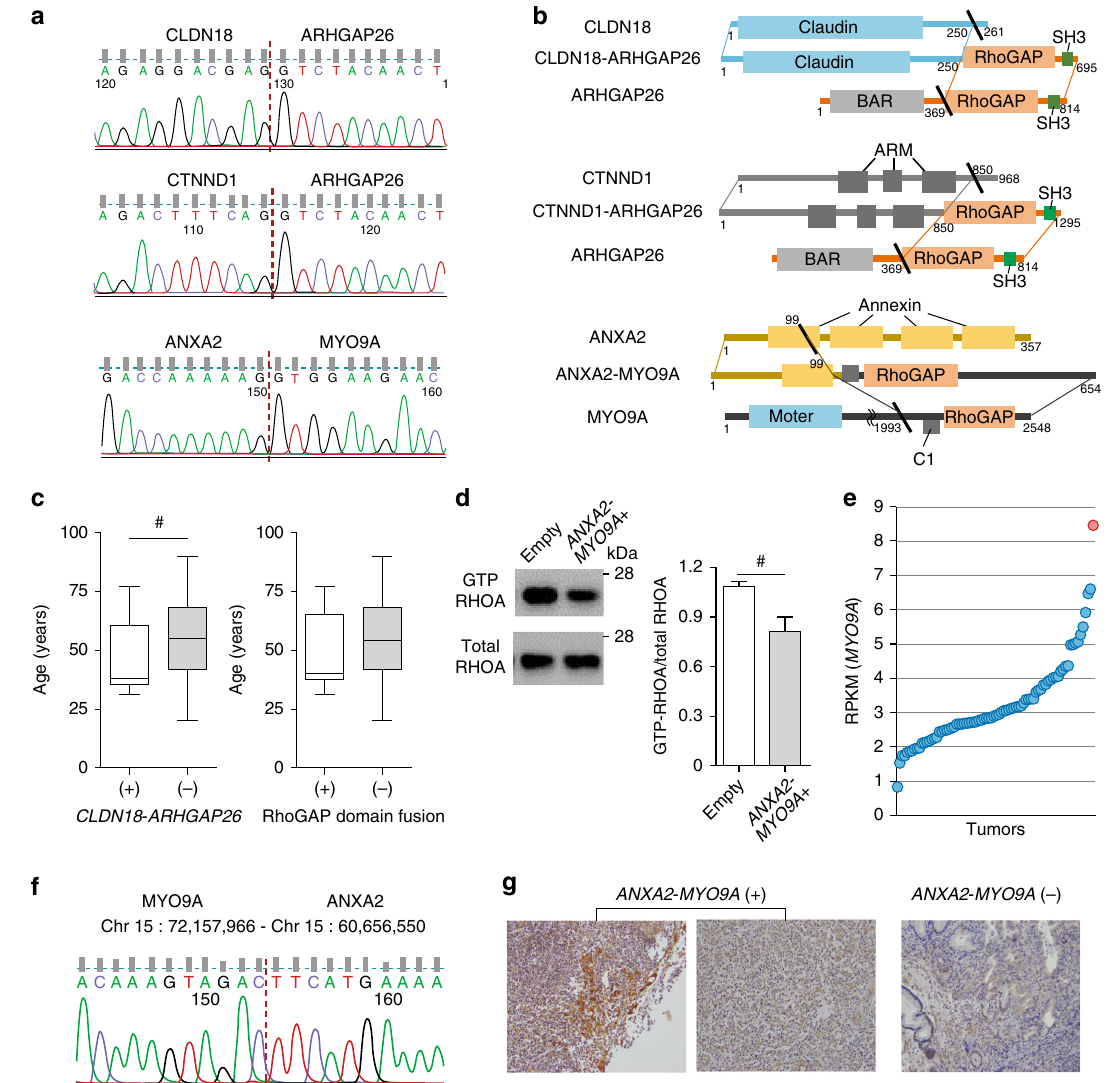
Fig. 2 Schematic representation of three recurrent RhoGAP domain-containing fusions ( a ) Chromatogram for the RT-PCR sequencing data. Dotted red lines, mRNA breakpoints. ( b ) Top panel, the CLDN18-ARHGAP26 fusion. Middle panel, the CTNND1-ARHGAP26 fusion was composed of the Armadillo (Arm) family domain of CTNND1 that is involved in cell-cell adhesion and signal transduction and RhoGAP and SH3 domains of ARHGAP26 . Bottom panel, the ANXA2-MYO9A fusion was composed of 99 amino acids in the N-terminal portion of ANXA2 and the protein kinase C conserved region 1 (C1) and RhoGAP domain of MYO9A . ( c ) Left panel, Age at the time of diagnosis was signi fi cantly lower in patients with the CLDN18-ARHGAP26 fusion (n = 13; left) than in those without (n = 371; right) (P = 0.042, Wilcoxon). Right panel, Age tended to be lower in patients with RhoGAP domain-containing fusions (n = 17; left) than those without (n = 367; right) (P = 0.10, Wilcoxon). Box plots display 5%, 25%, median, 75%, and 95%. (d) RhoTekin assay in 293FT cells following the ectopic expression of Anxa2-Myo9a fusion. Relative value of GTP-RHOA to total RHOA as measured by a densitometry in three independent experiments. Error bars, mean ± SEM. ( e ) RPKM values for MYO9A in 80 early-onset DGCs (dots) in a discovery dataset. Each circle represents each tumor. Blue circle, a tumor expressing the ANXA2-MYO9A fusion. ( f ) PCR sequencing chromatogram for genomic DNA isolated from a tumor expressing the ANXA2-MYO9A fusion. Dotted line, chromosomal breakpoint. ( g ) MYO9A immunohistochemistry images were taken at 200 × . Left, Two